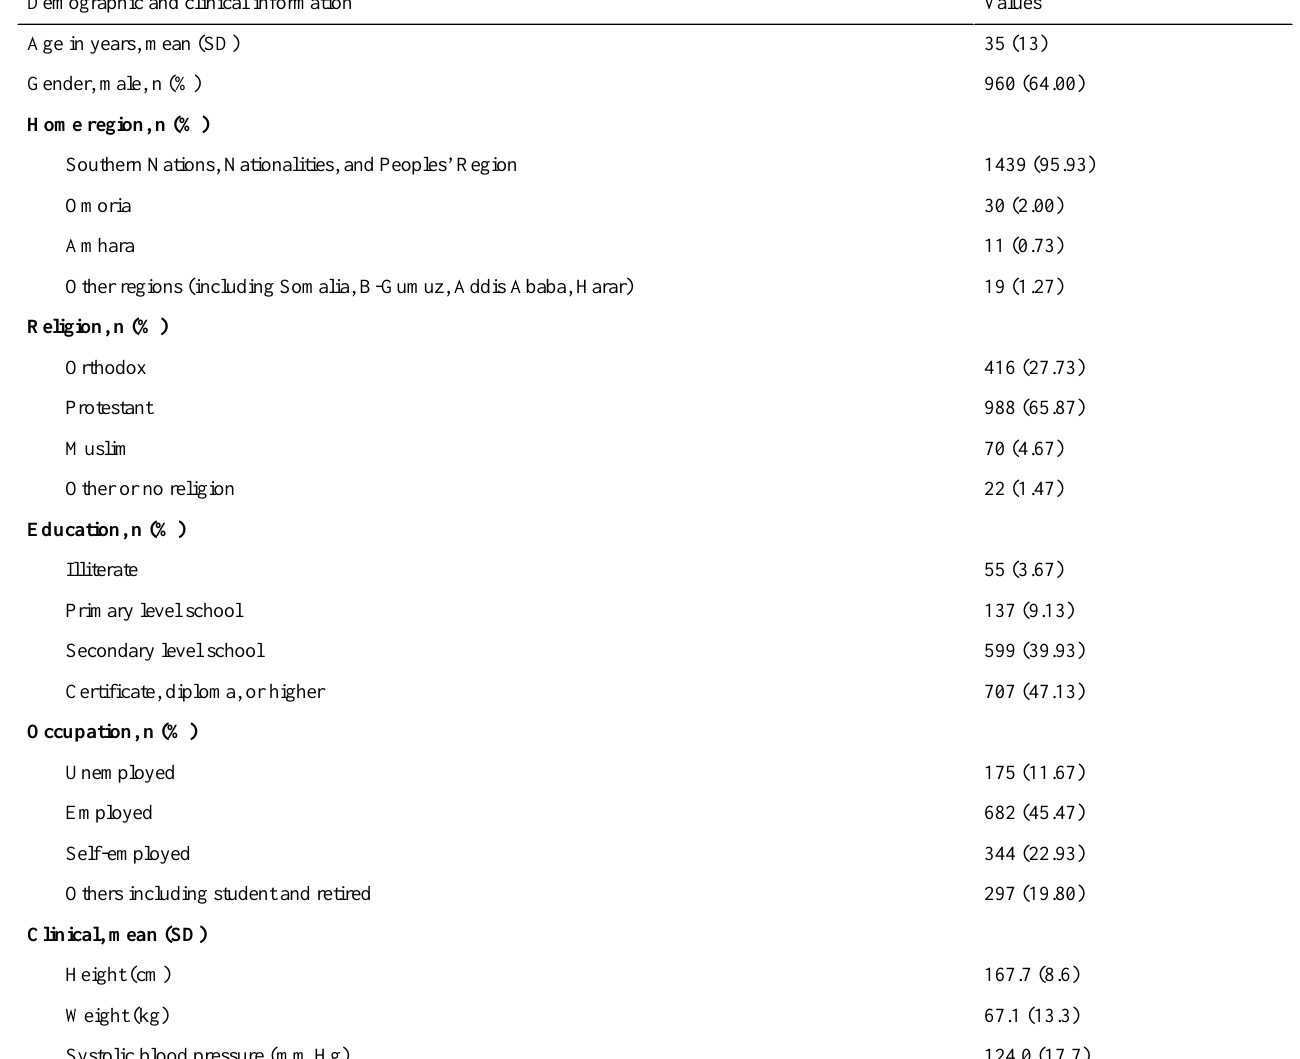
Table 1. Baseline clinical characteristics